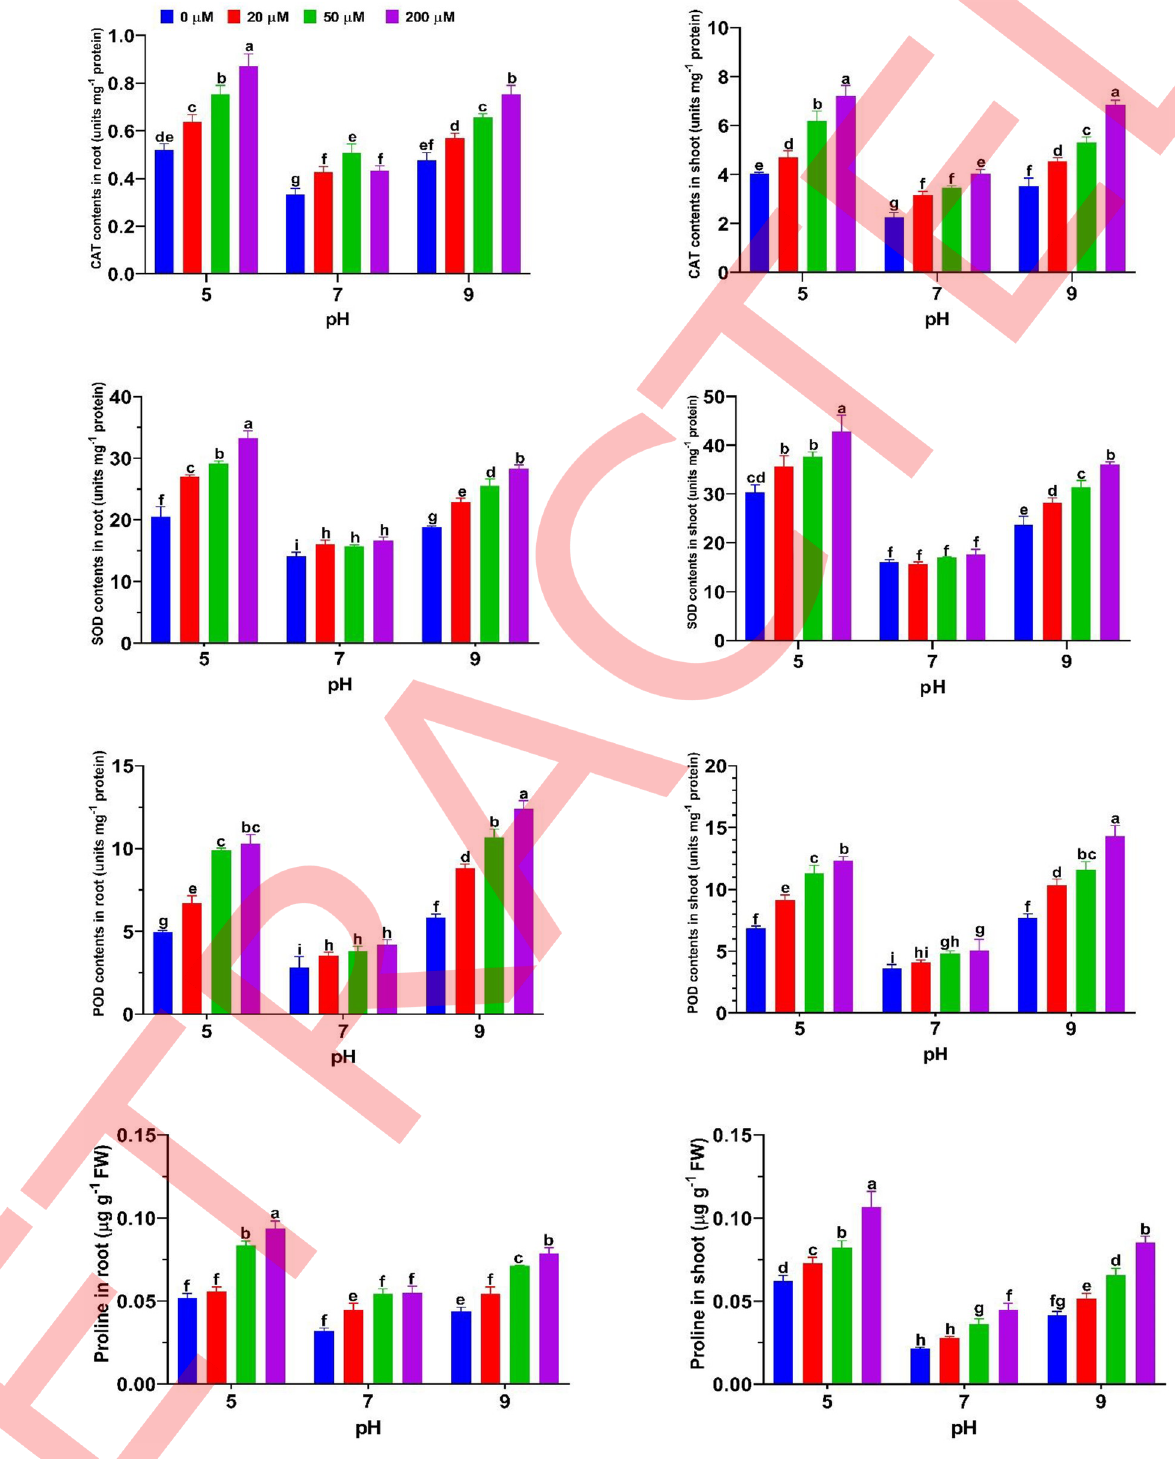
Fig 3. Effect of three different levels of pH (5, 7, and 9) on roots and shoots enzymatic (catalase; CAT, superoxide dismutase; SOD, and peroxidase; POD) and non-enzymatic (proline) contents of cadmium (0, 20, 50, and 200)-stressed wheat plants.